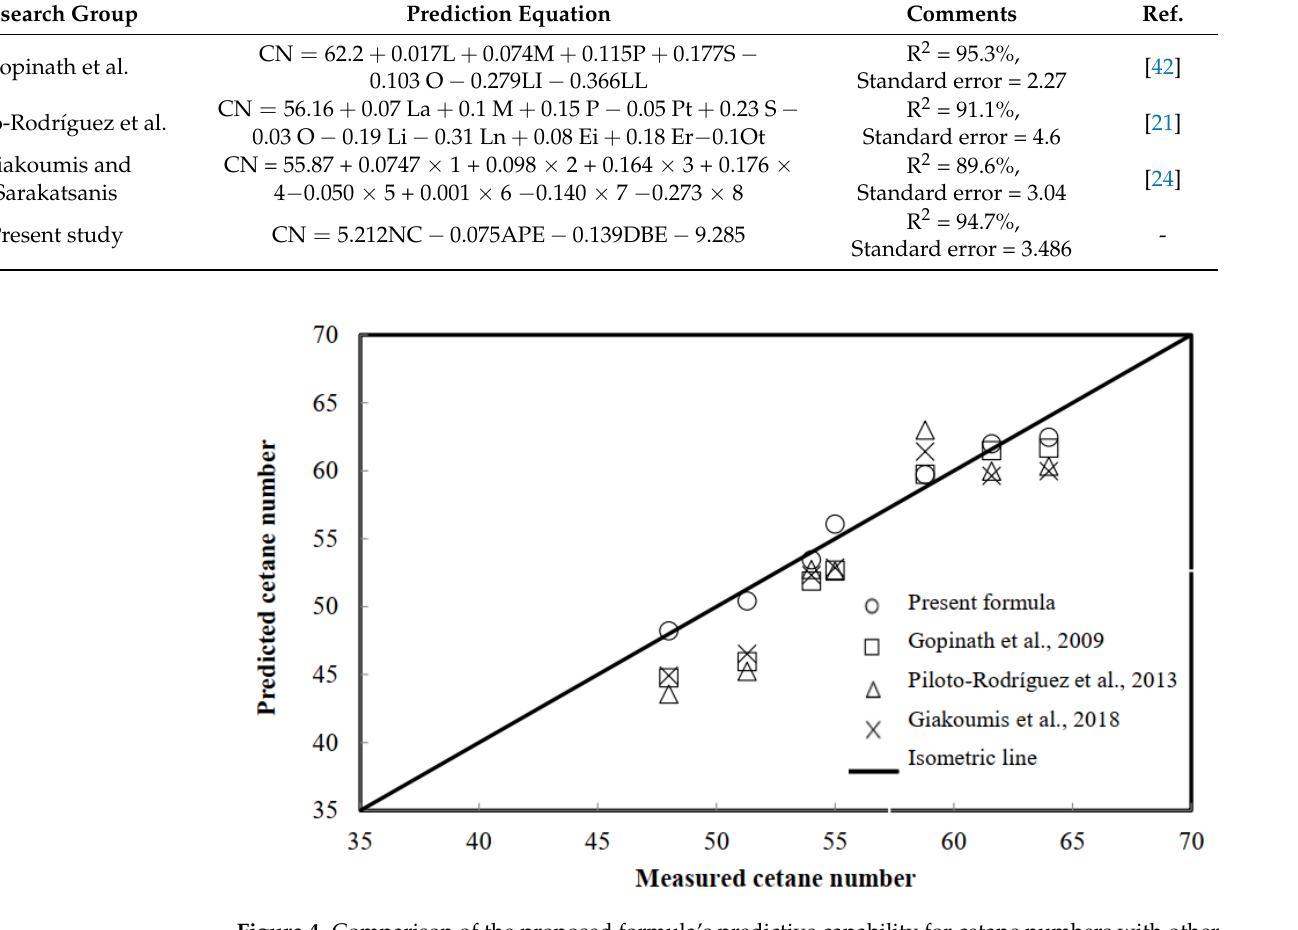
Figure 4. Comparison of the proposed formula’s predictive capability for cetane numbers with other competitive formulae in the literature [21,24,42]. competitive formulae in the literature